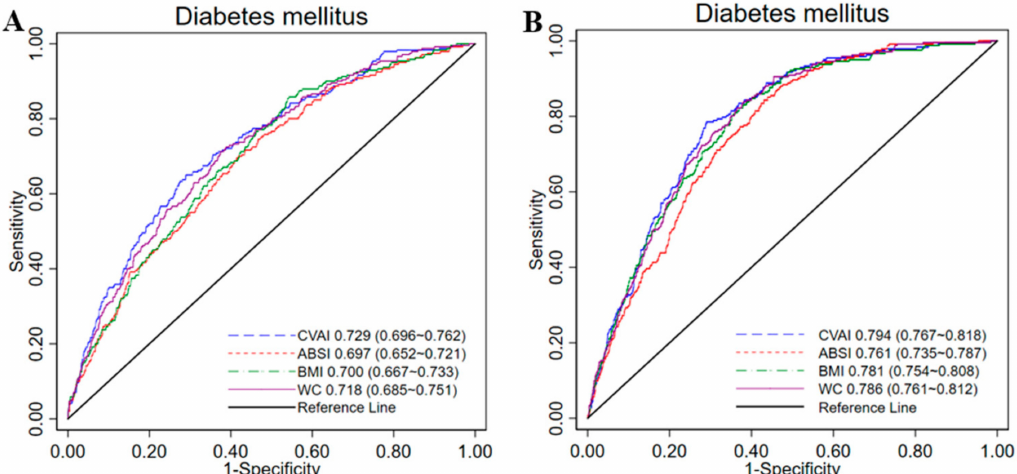
Figure 1. The ROC curves of CVAI, ABSI, BMI and WC for diabetes among men ( A ) and women ( B ) in China. ROC, receiver-operating characteristic; CVAI, Chinese visceral adiposity index; ABSI, a body shape index; BMI, body mass index; WC, waist circumference; AUCs, area under curves. AUCs were 0.729 and 0.794 for diagnosis of diabetes for men and women, respectively, and this is significantly better than ABSI, BMI and WC in Chinese adults (All p <